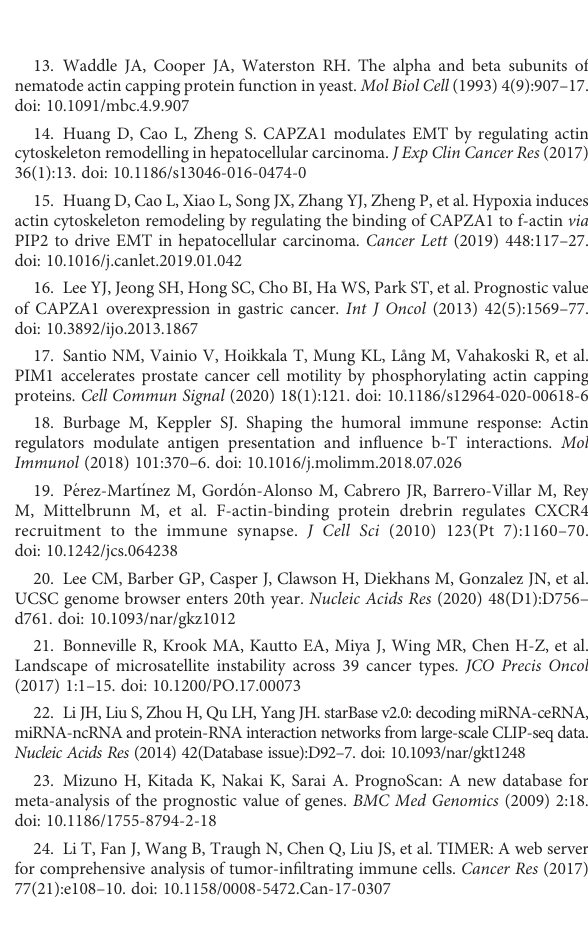
SUPPLEMENTARY FIGURE 2 The lncRNAs of the miR-30d-5p regulatory network are established by cytoscape